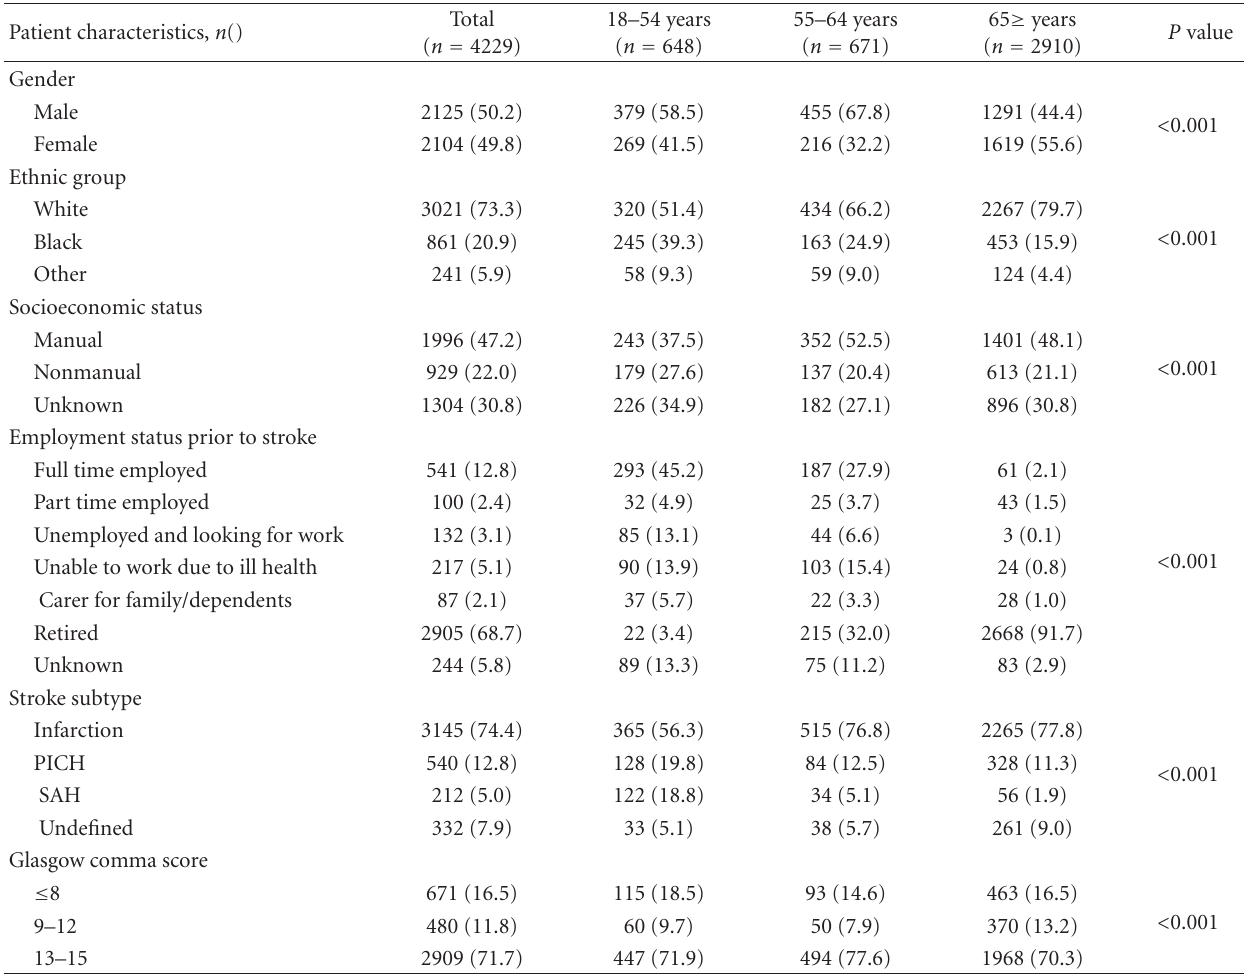
Table 1: Patient characteristics by age